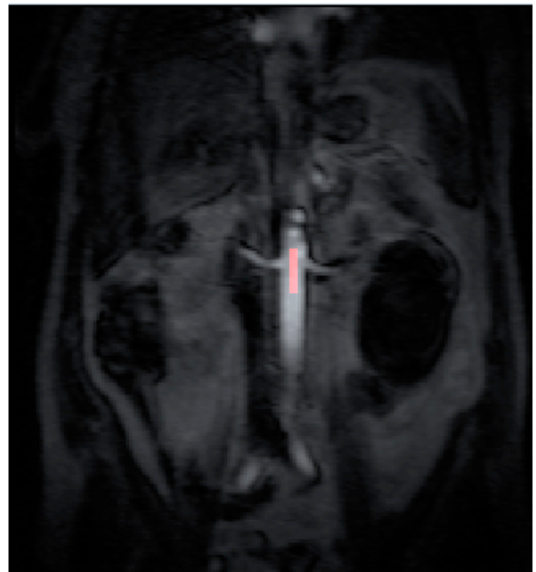
Figure 1. The arterial input function (AIF) region of interest (ROI) was drawn inside the aorta at the approximate level of the origin of the vascular pedicles of the kidneys in the dynamic series.